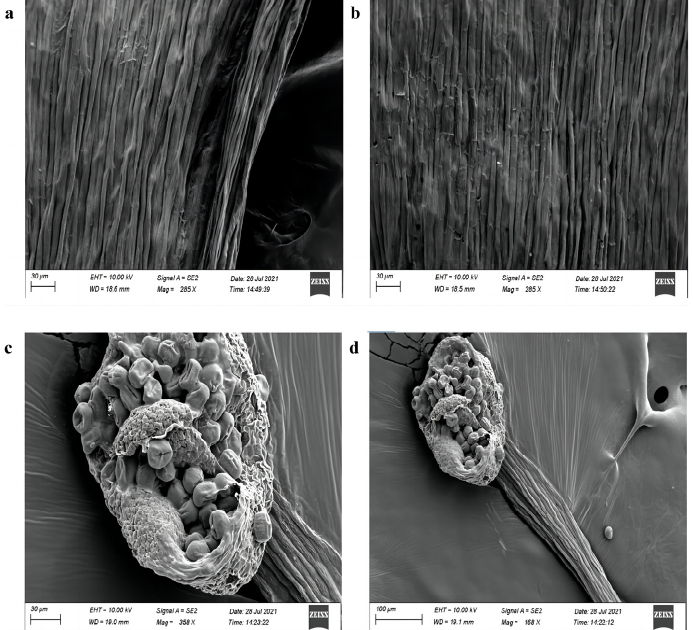
Figure 10. Comparison of scanning electron microscope results of petals between transgenic plants and wild-type plants. ( a , c , e ) OE-GmAP3 soybean; ( b , d , f ) wild-type plant.